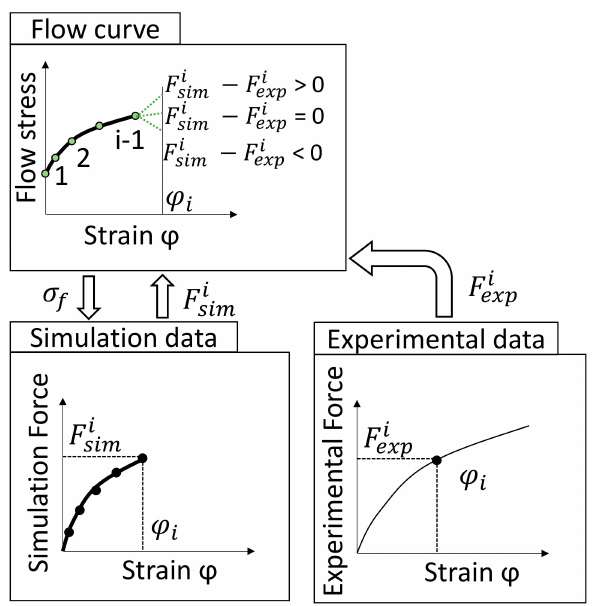
Figure 1. Illustration of piecewise flow curve determination based on the concept put forward by Kamaya et al.